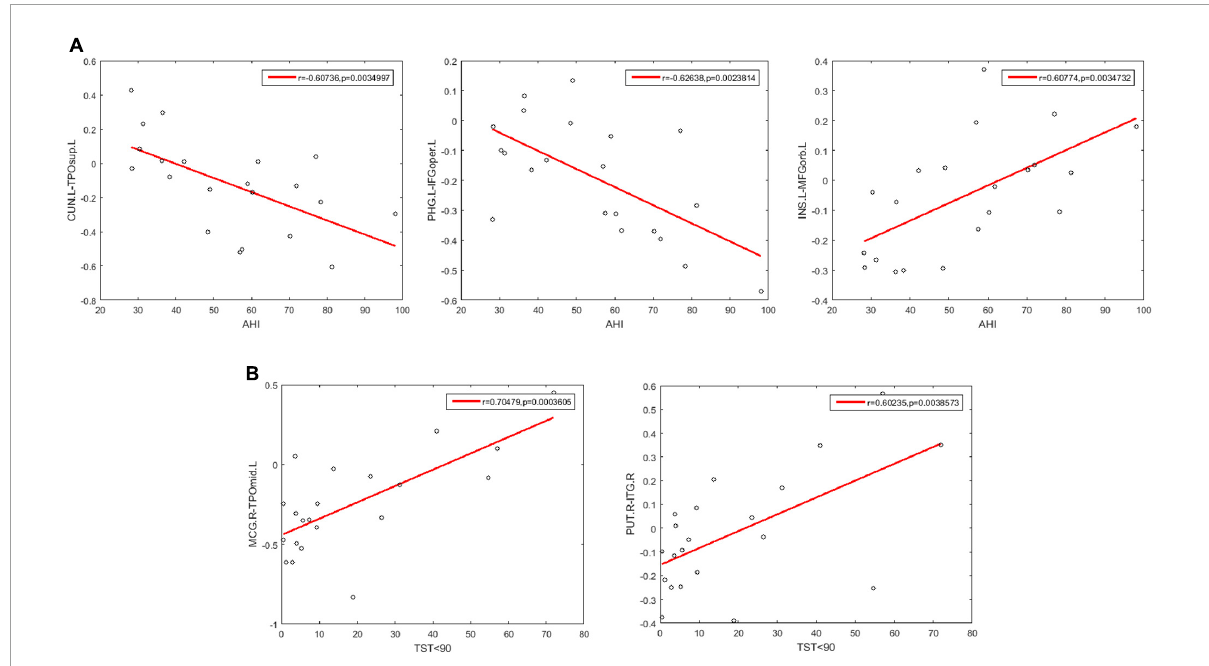
FIGURE7 Scatter plots showing significant correlations between the FCs and the clinical variables in patients with OSA. (A) The correlations between the FCs and AHI. (B) The correlations between the FCs and % TST < 90%. AHI, apnea-hypopnea index; %TST < 90%, percentage of total sleep time spent at oxygen saturations less than 90%; CUN.L, left Cuneus; TPOsup.L, left Temporal pole: superior temporal gyrus; PHG.L, left Parahippocampal gyrus; IFGoper.L, left Inferior frontal gyrus, opercular part; INS.L, left Insula; MFGorb.L, left Middle frontal gyrus, orbital part; MOG.R, right Middle occipital gyrus; TPOmid.L, left Temporal pole: middle temporal gyrus; PUT.R, right Lenticular nucleus, putamen; ITG.R, right Inferior temporal